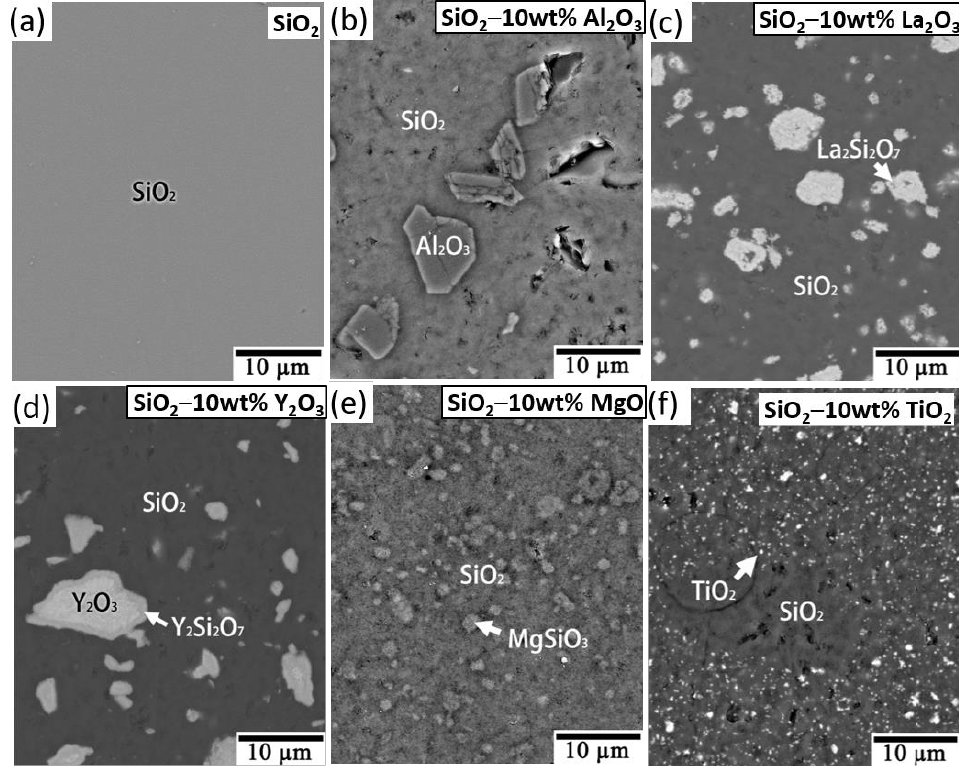
Figure 4. BEIs/SEM images of ( a ) SiO 2 and ( b – f ) SiO 2 with 10 wt.% Al 2 O 3 , La 2 O 3 , Y 2 O 3 , MgO, and TiO 2 , respectively.